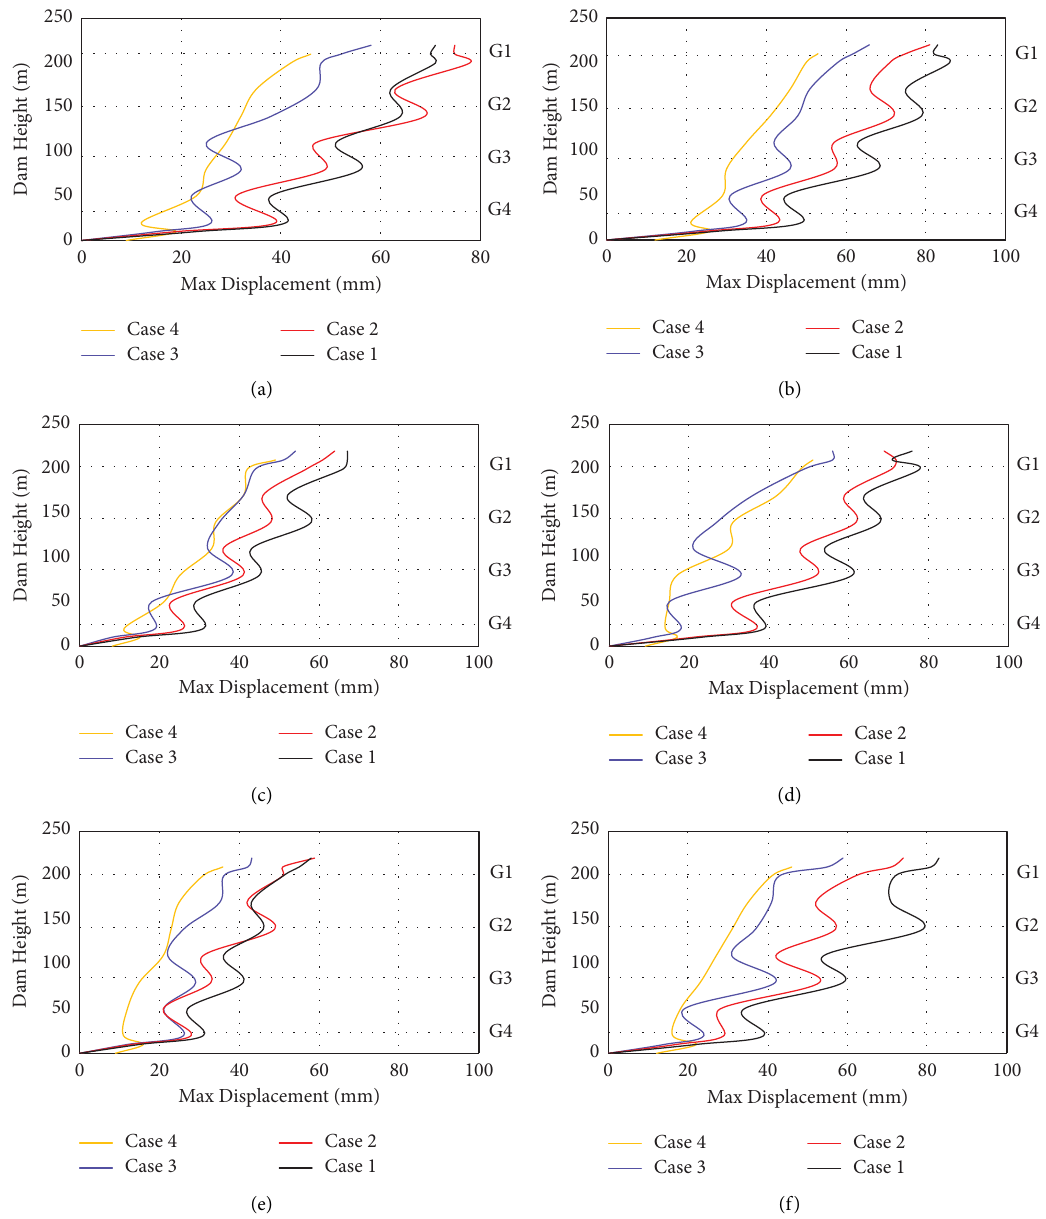
Figure 11: Earthquake displacement results of Ermenek arch dam for EQ13–EQ18 earthquakes: (a) EQ13, (b) EQ14, (c) EQ15, (d) EQ16, (e) EQ17, and (f)